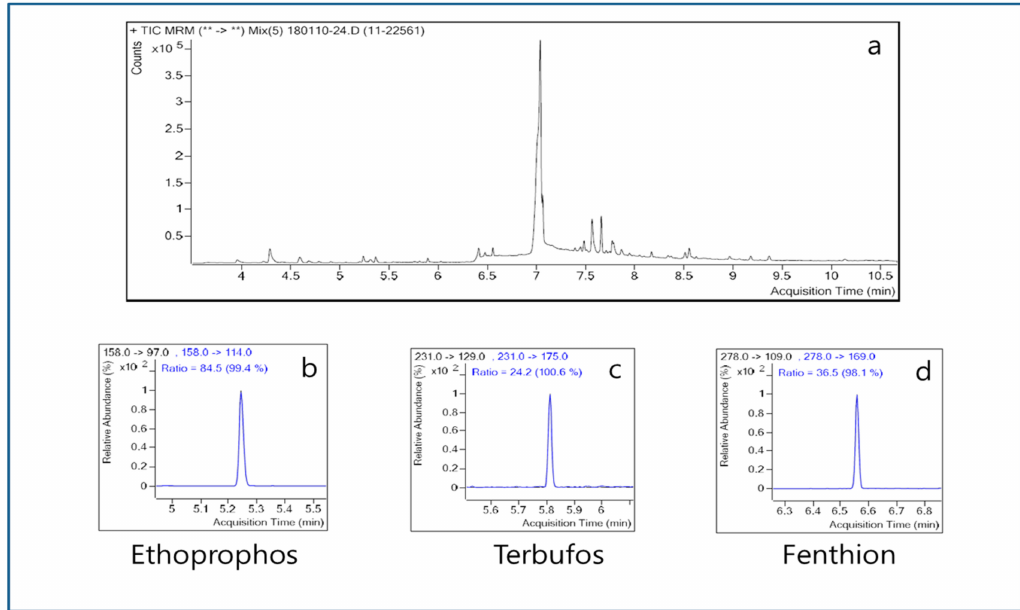
Figure 3. Identification of contaminating pesticides in the distillers’ stillage obtained from single-stage distillation. ( a ) Distillers’ stillage; ( b ) ethoprophos; ( c ) terbufos; ( d )